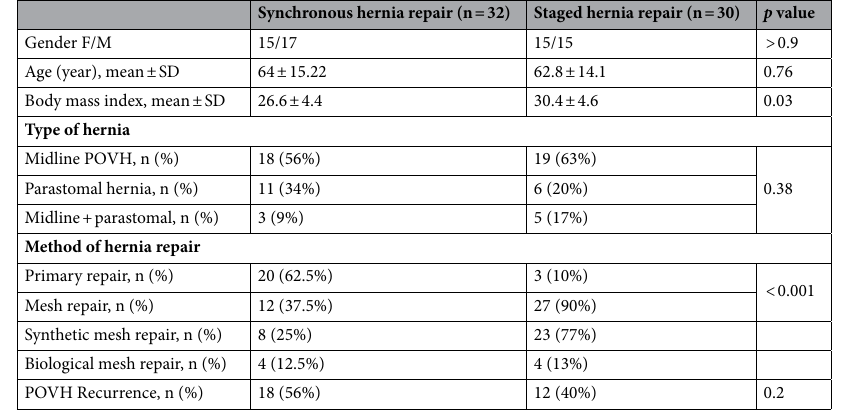
Table 4. Comparison between synchronous hernia repair group and staged hernia repair group—detailing types of hernias, methods of repair and recurrence rate. POVH post operative ventral